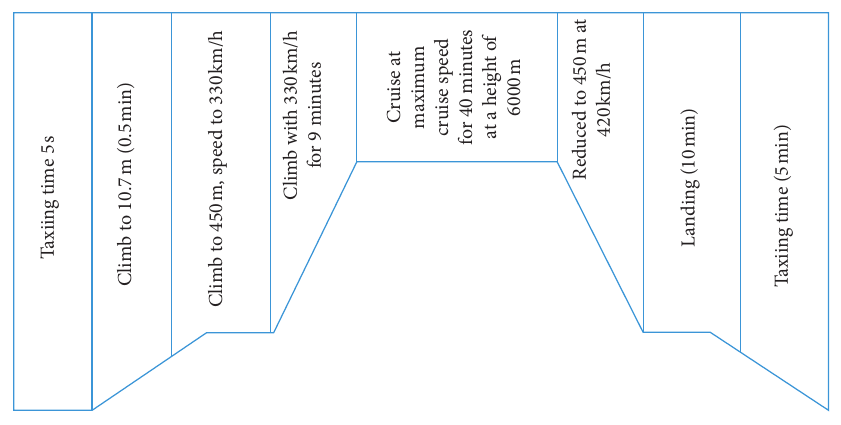
Figure 3: Typical mission